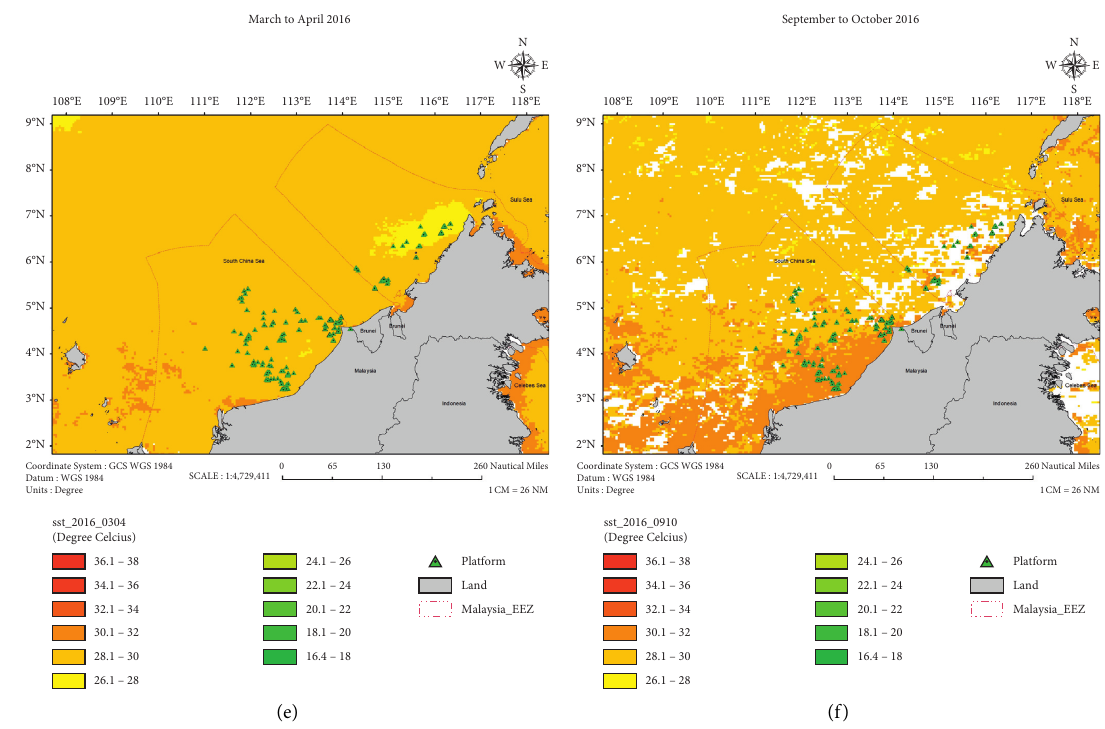
Figure 5: Sea surface temperature (SST) in Malaysia during March to April and September to October 2016. (a, b) North of Peninsular Malaysia. (c, d) South of Peninsular Malaysia. (e, f) Sabah and